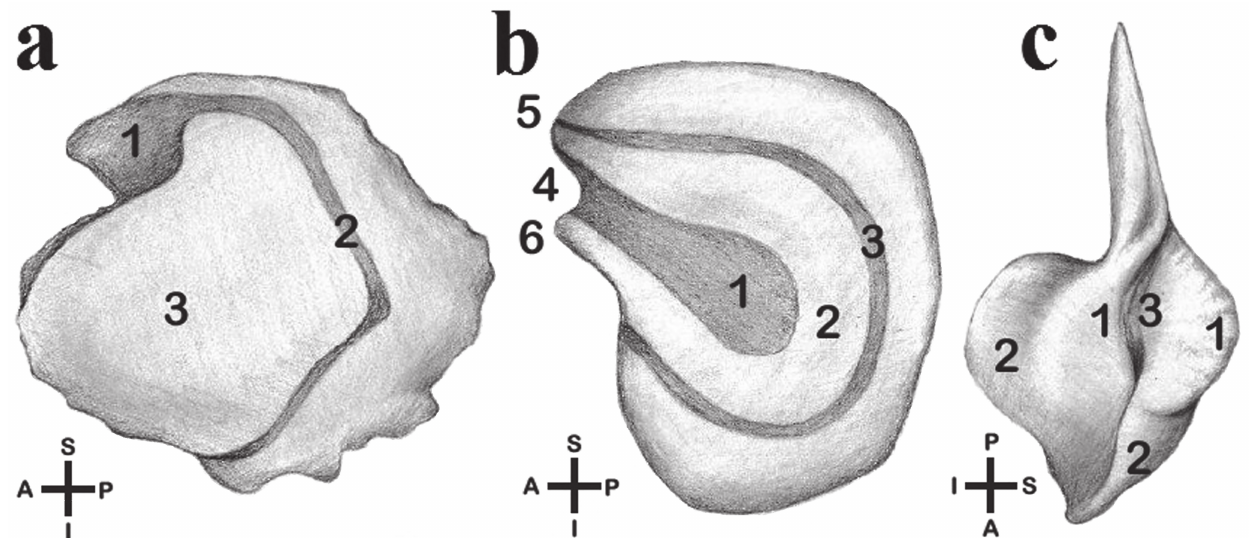
Fig. 2. General structure and morphological features of the three otoliths (a) Lapillus. 1 , sulcus; 2 , sulcus minor; 3 , mond. (b) Asteriscus. 1 , fossa acustica; 2 , crista; 3 , canalículum; 4 , excisura; 5 rostrum; 6 , antirrostrum. (c) Sagitta. 1 , dorsal wings; 2 , basal wings; 3 , fissura. In all the cases A , anterior region; P , posterior region; S , superior region; I , inferior